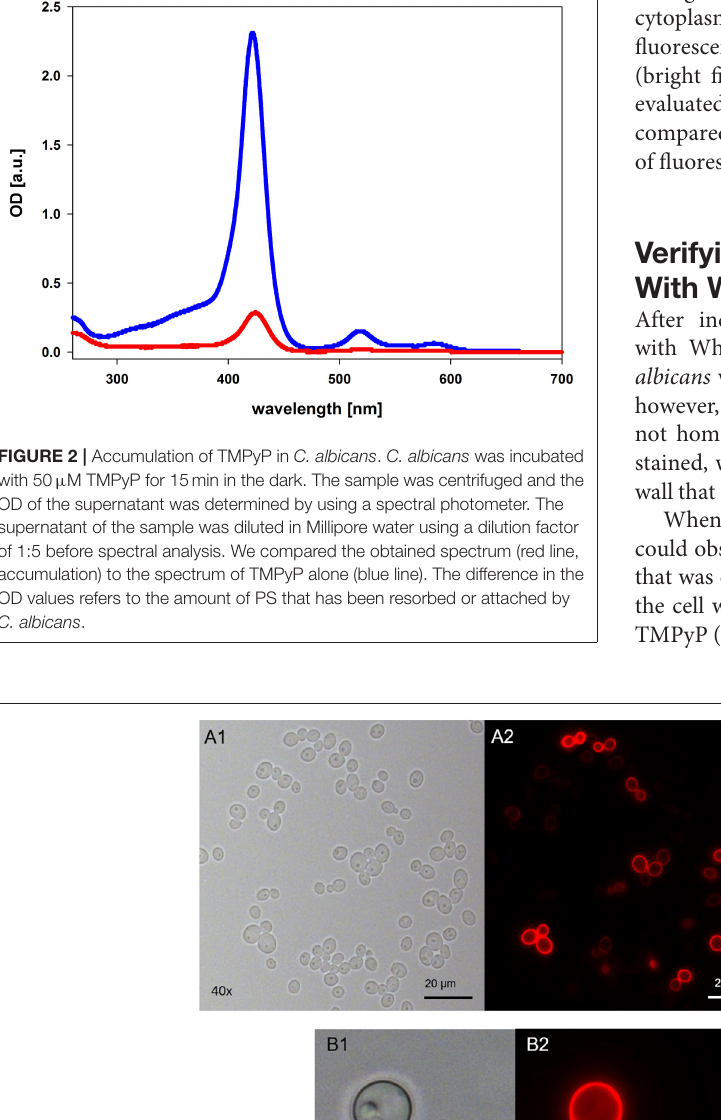
Frontiers in Medicine |